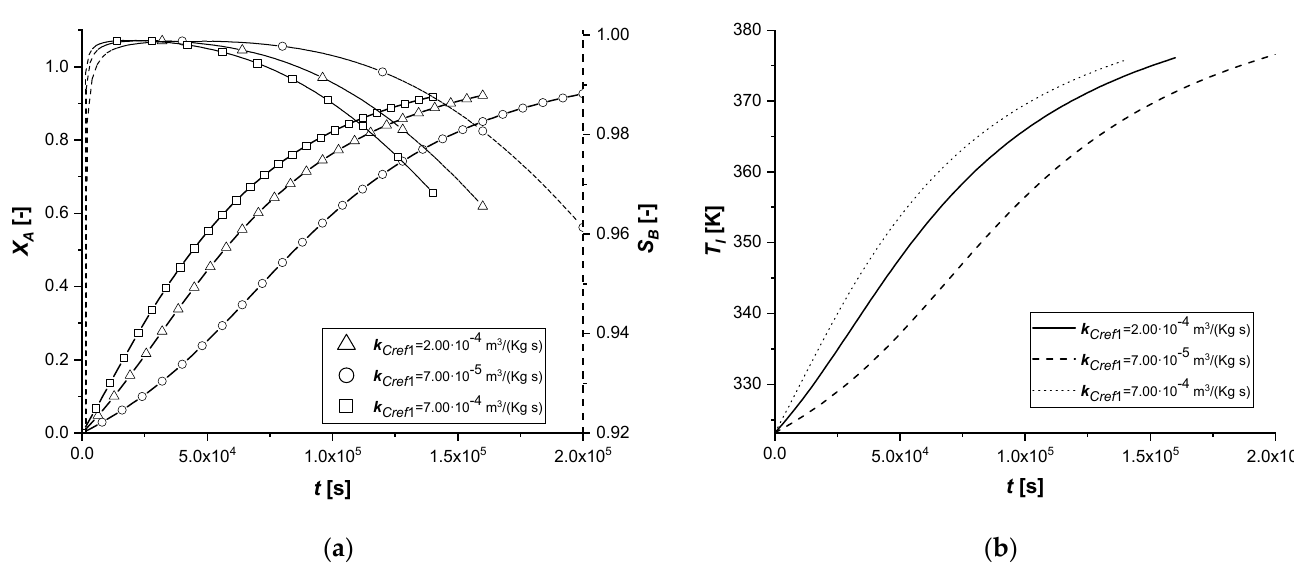
Figure 13. EY k Cref 1 investigation. ( a ) Bulk profiles over time of X A and S B . ( b ) Bulk profile of T l over time. As the kinetic parameter increases, both reactive processes are accelerated. If for the first reaction the increase in the rate is evident, the second receive an improvement due to the high concentration of B, because its kinetics of first order with respect to the interme- diate. It is interesting to note that unlike the first set of enthalpy simulations, the decreasing trend on the liquid side of c Bl is not observed in the EW and EY cases. The second chemical reaction is less affected than the Δ H 1 study. In these simulations, in the cases of EW and EY, the consumption of A is clearly limited by internal diffusion resistance. With the consequent decrease of the kinetic constant, the reaction times increase moderately, showing a growth in the production of the by-product C, especially in the ES case. Also in this study, the use of ES type catalysts can be favored if the desired product is the intermediate one. The comparison between the solid side and liquid side concentration profiles calcu- lated for all the cases, varying the second-rate constant, are reported in Supplementary Materials in Figures S28–S36. The details of each conversion, selectivity, and liquid side temperature profiles are displayed in Figures 14–16.